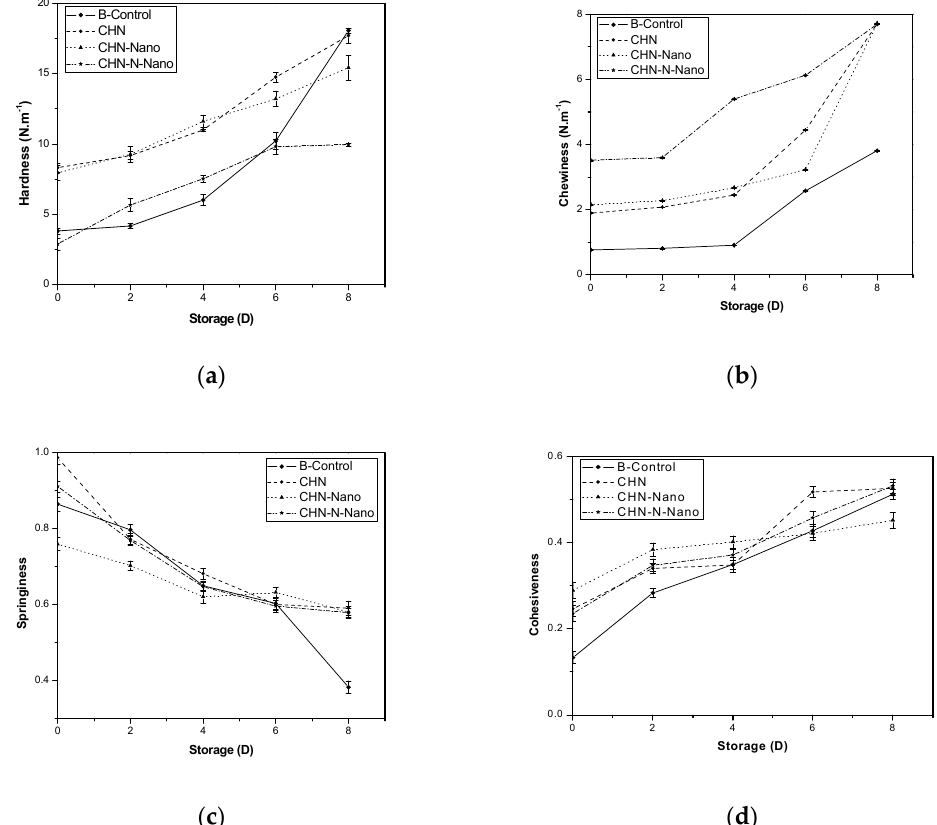
Figure 2. Effects of coating on texture profile analysis parameters for blueberry samples under ambient temperature, ( a ) Hardness; ( b ) Chewiness; ( c ) Springness and ( d ) Cohesiveness.